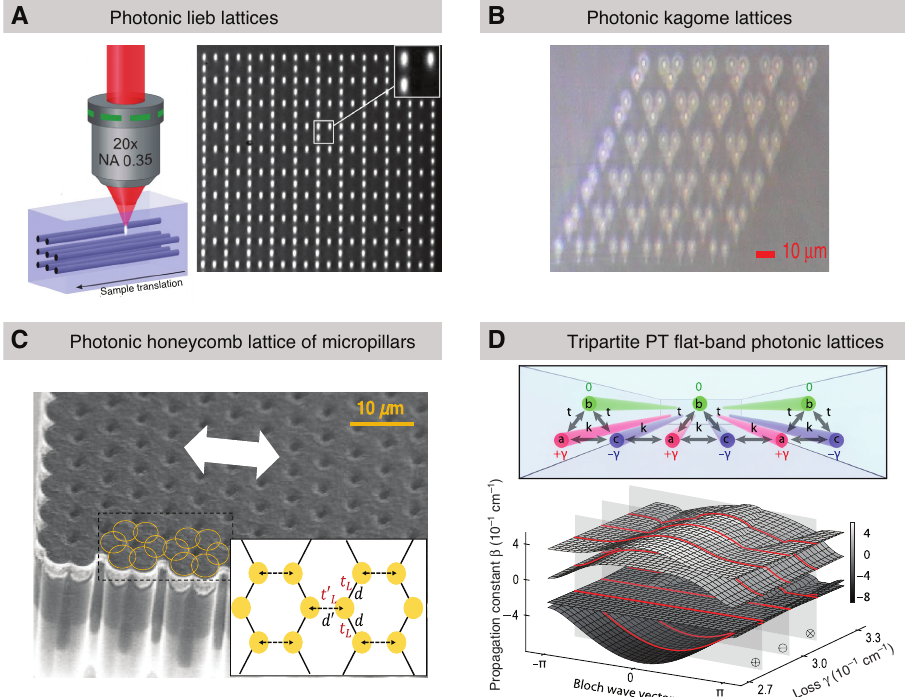
Figure 1: Examples of laser-written and engineered flat-band photonic lattices. (A) A photonic Lieb lattice established by fs-laser-writing technique for demonstration of flat-band compact localized states [32]. (B) A photonic Kagome lattice established for demonstrating topological corner states exhibiting a remarkable degree of flexibility and control [55]. (C) A photonic honeycomb lattice of micropillars engineered with type-III Dirac cones that combine flat and linear dispersion bands [56]. (D) Schematic of the tripartite PT-symmetric photonic lattice and resulting dispersion relation showing the partially flat band around the exceptional point of the structure